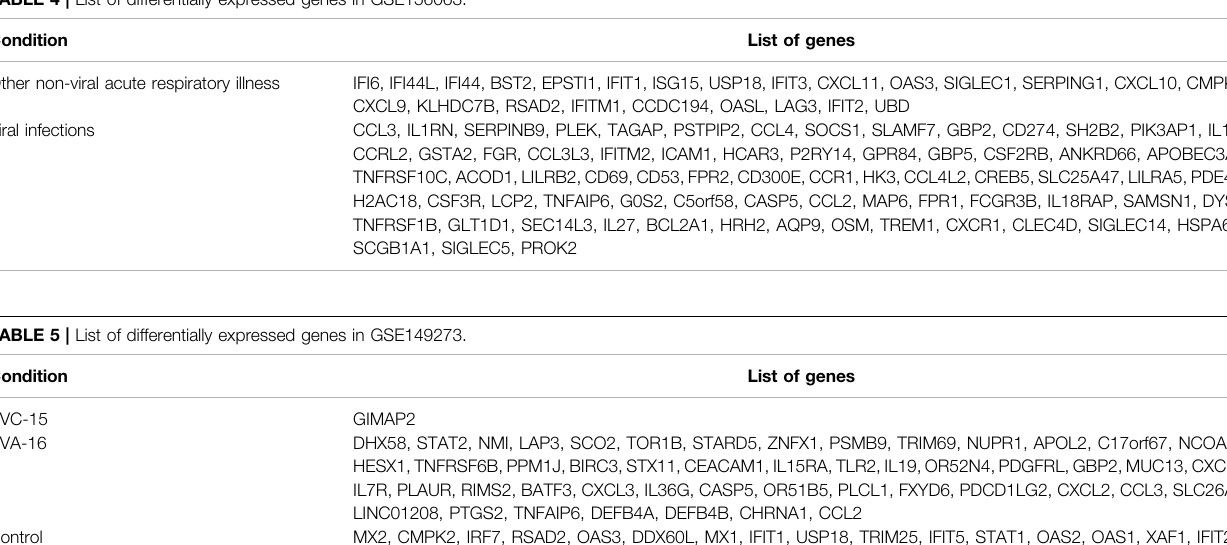
TABLE 4 | List of differentially expressed genes in GSE156063.